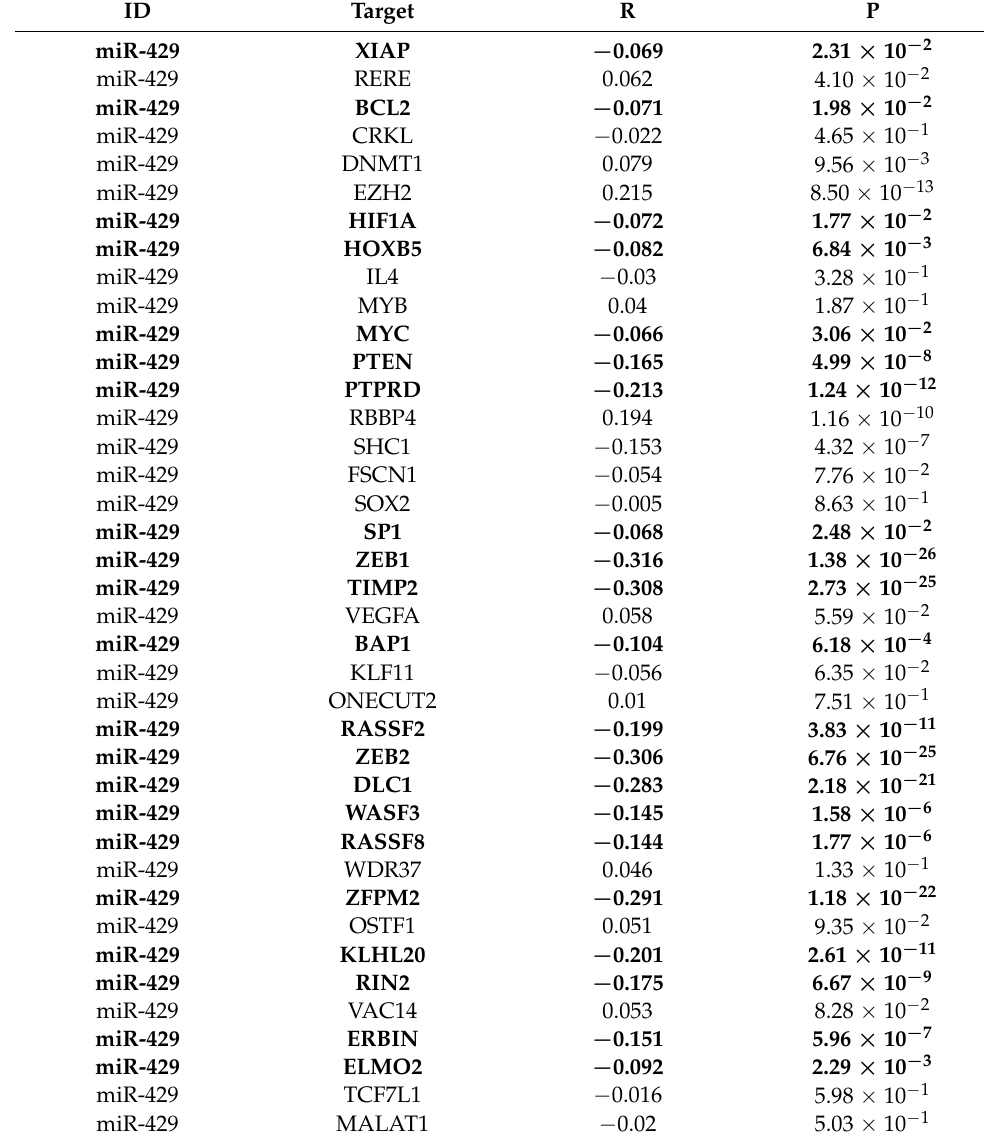
Table 2. The expression correlation of miR-429 with its predicted binding target genes in breast cancer determined by